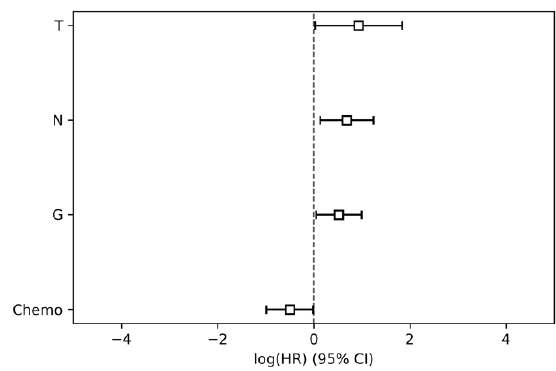
Figure 1. Hazard ratios and 95% confidence intervals of parameter group 1 (clinical parameters). HR,